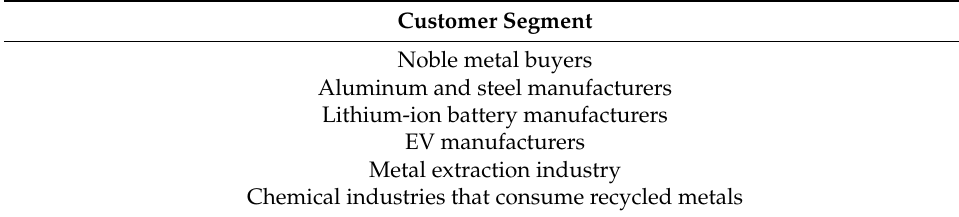
Table 12. Market segment for LIB recycling business model.